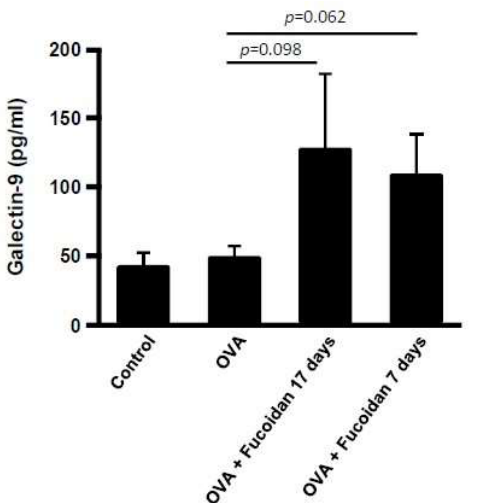
Figure 4. Galectin-9 level in blood plasma of mice administered F-fucoidan. Mice were immunized by injection of OVA and administrated F-fucoidan orally (60 µ g / mouse / day) as described in the Materials and Methods. Whole blood was collected by cardiopuncture 1 day after OVA challenge and plasma was obtained. The concentration of galectin-9 in blood plasma was measured by ELISA. Values represent means ± SEM of 4 − 5 mice in each group.